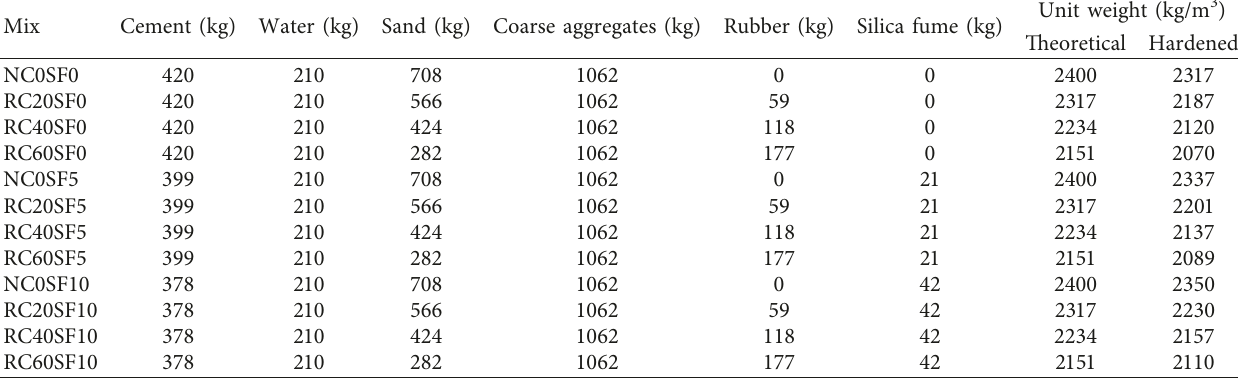
Table 2: Concrete mix proportions of rubber fiber concrete with and without silica